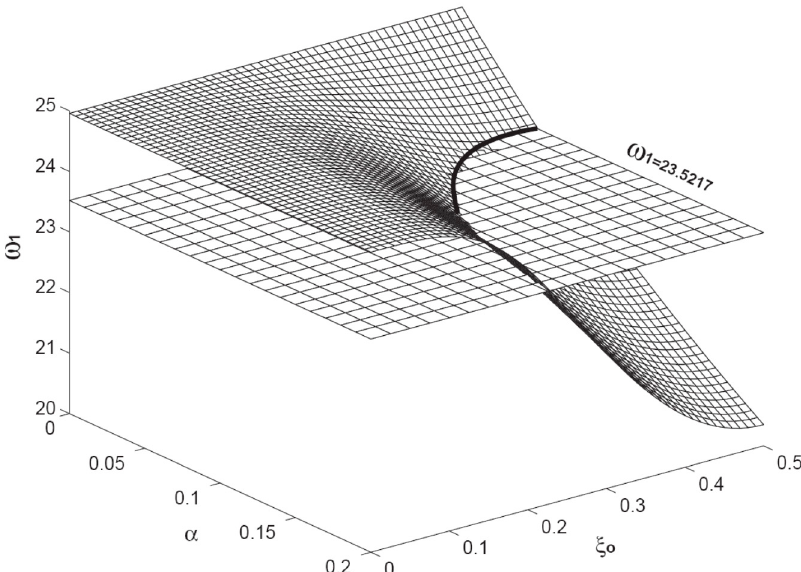
ω ) as a function of α and ξ . The 1 o ω = 23.5217. The intersection of the two planes 1